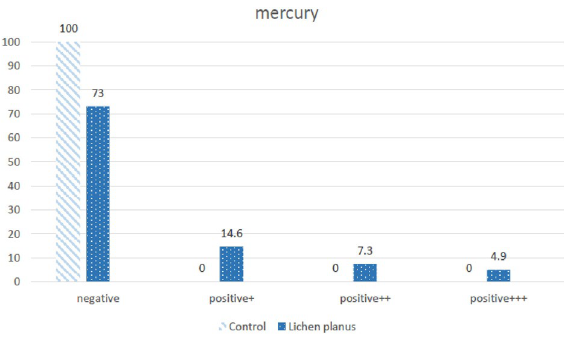
Figure 1. Results of mercury tests in Oral Lichen Planus and control groups.